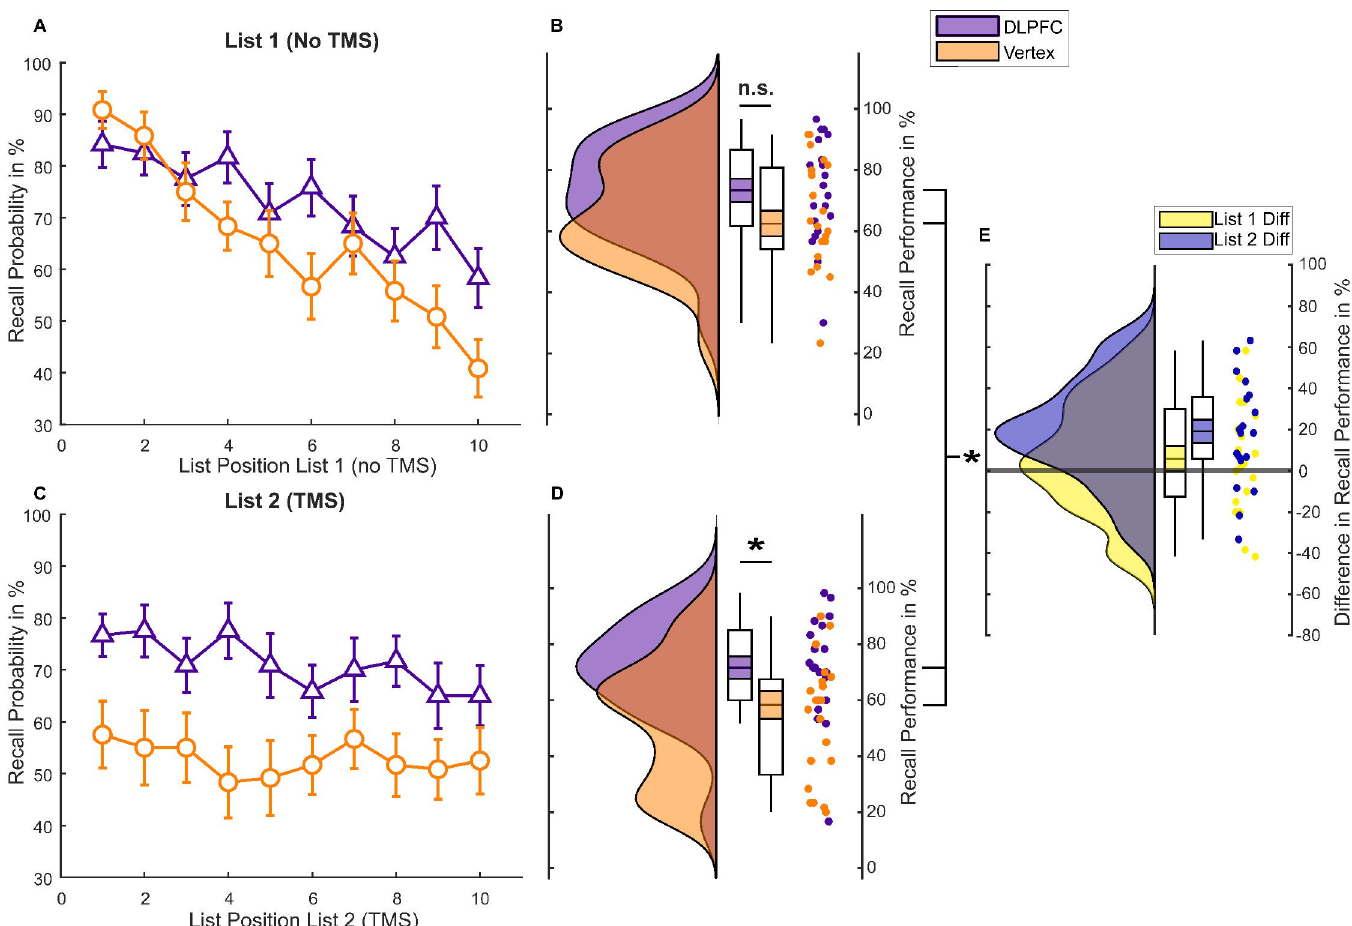
Fig 2. Behavioural memory performance in experiment 1. (A) Serial position curve for List 1 words. Error bars depict standard errors of the mean. (B) Raincloud plots of average memory performance for List 1 words across all blocks with paired boxplots [16]. Coloured area within the box plots indicate the standard error, while the circles depict individual data points. (C) Serial position curve for List 2 words. Error bars depict standard errors of the mean. (D) Memory performance for List 2 words. (E) Difference in average memory performance between the DLPFC and vertex condition for each list (List 2 = Stimulation). The data and scripts used to generate this figure can be found at https://osf.io/dyxjv/. DLPFC, dorsolateral prefrontal cortex; n.s., not significant; TMS, transcranial magnetic stimulation.